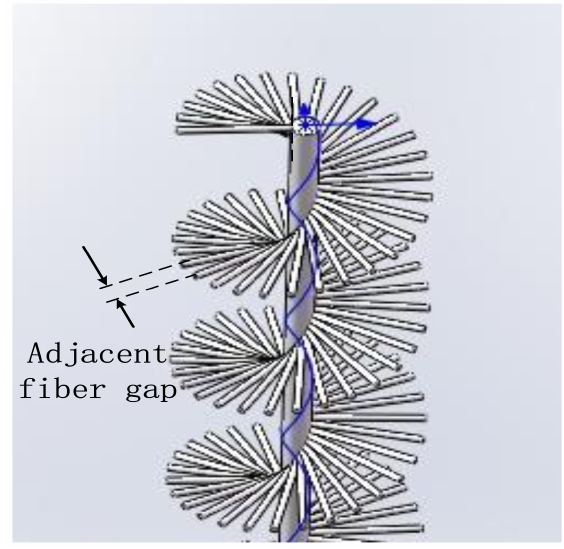
Figure 4. Flexible helix blade clearance